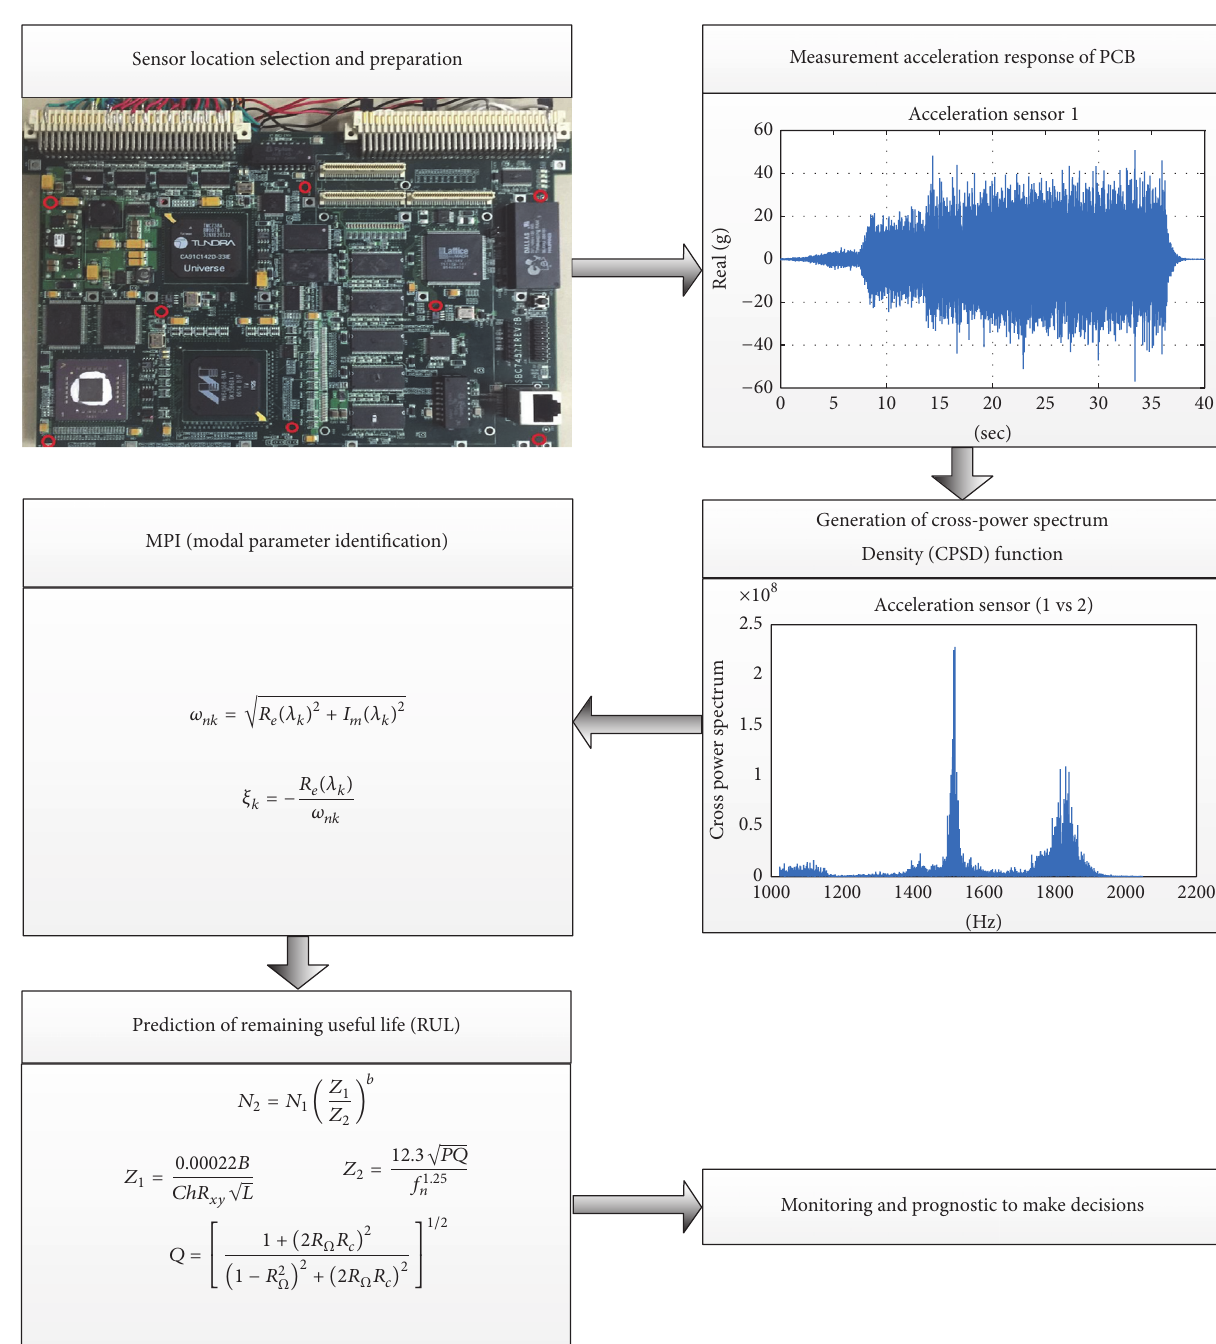
Figure 1: Proposed prognostic method of electronic devices under vibration